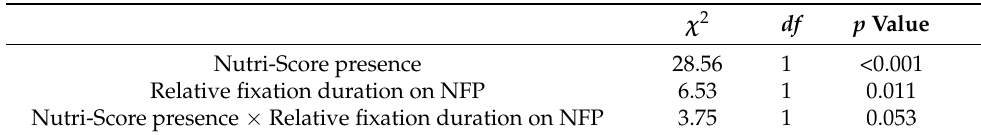
Table 8. The fixed part of the mixed-effects model with random slopes for Nutri-Score in the subset of participants exposed to products with NFP.